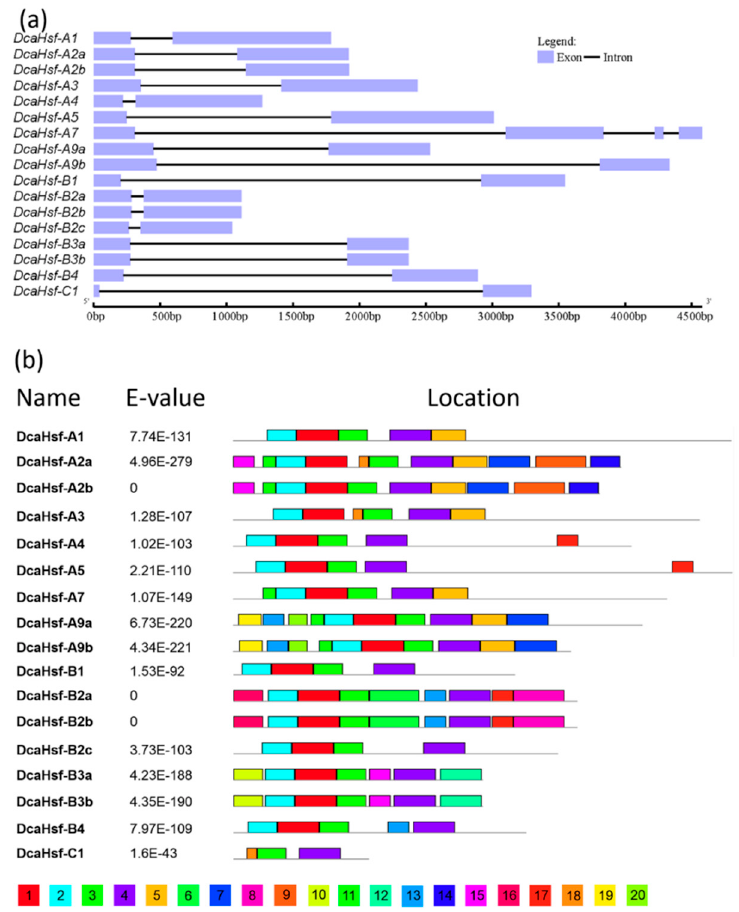
Figure 3. Intron and exon structure ( a ) and amino acid motifs ( b ) of members of the DcaHsf family. ( a ) Boxes and lines represent exons and introns, respectively. ( b ) A total of 20 conserved motifs were identified using Multiple Em for Motif Elicitation (MEME).